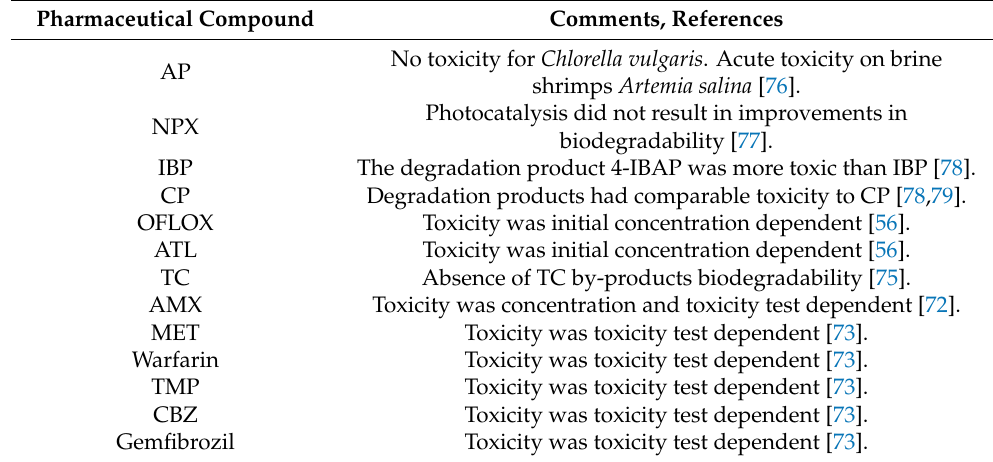
Table 4. Pharmaceutical Compounds with Reported Toxic Photocatalytic Degradation By-Products. Pharmaceutical